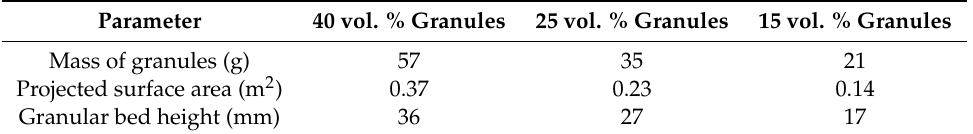
Table 4. Basic properties of the layer of AC granules used in the MFCs of 2–4 mm in diameter and 0.57 g/cm 3 in bulk